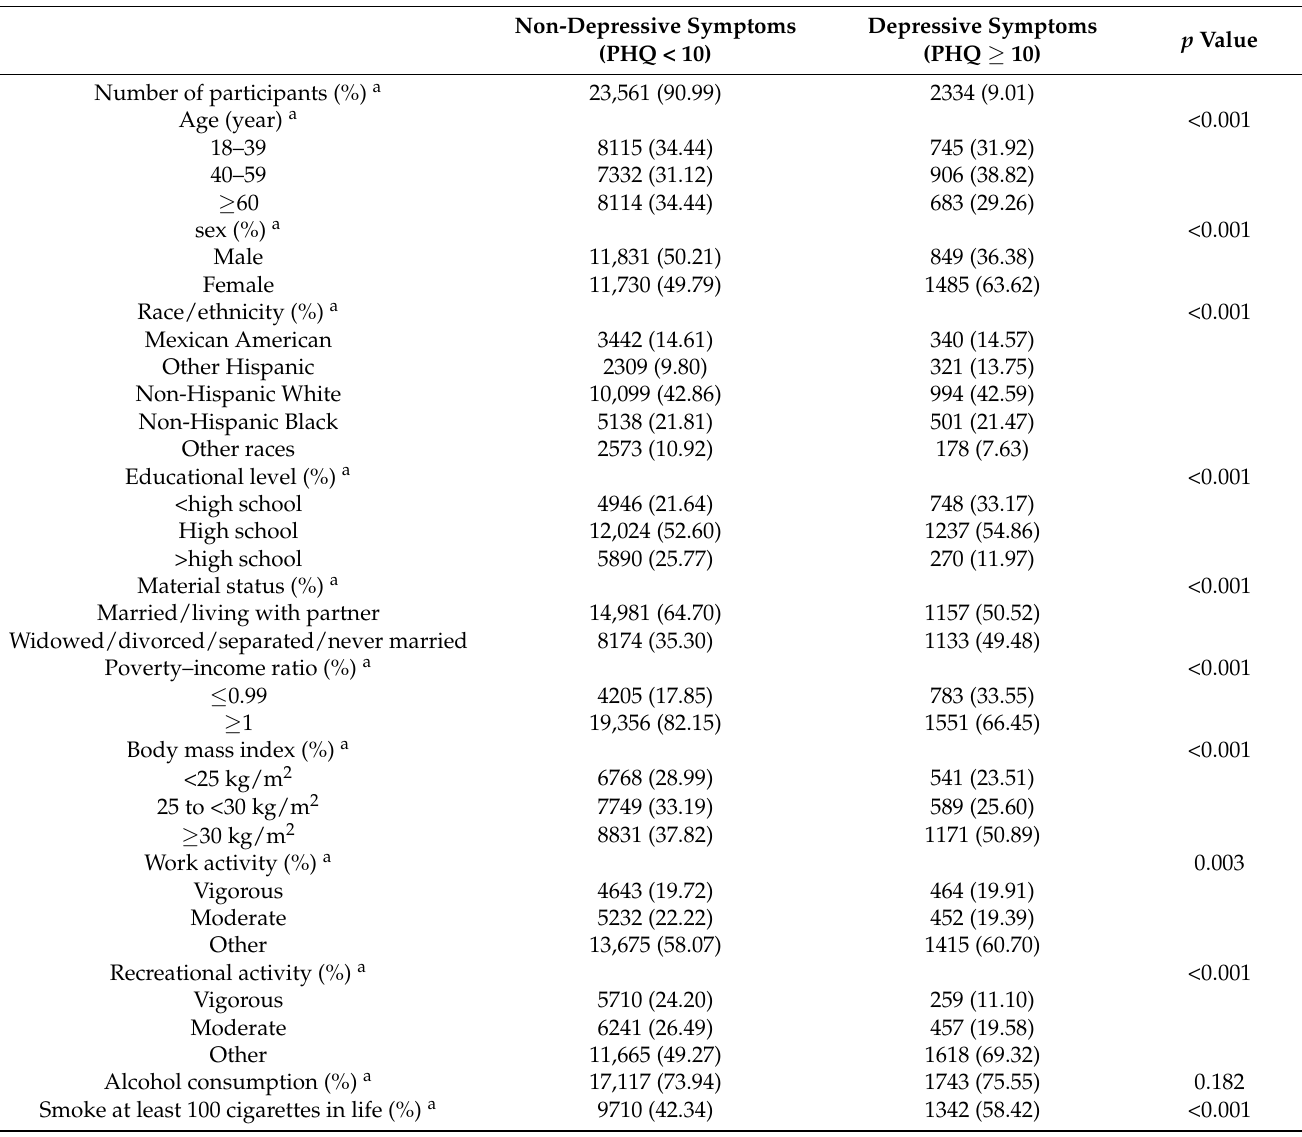
Table 1. Baseline characteristics of participants by depressive symptoms, NHANES 2007–2018 ( N = 25,895).